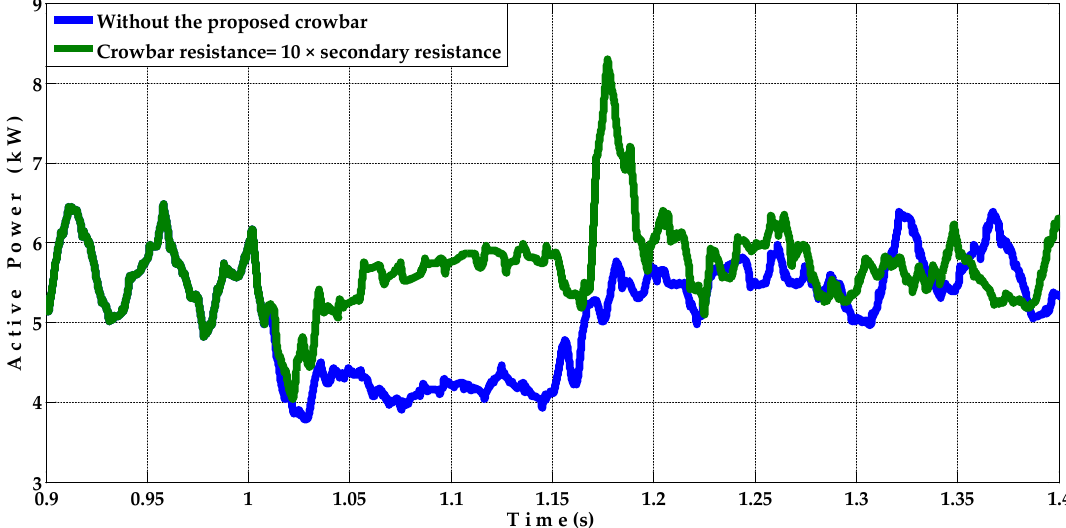
Figure 14. Active power of BDFRG with and without the proposed crowbar under single-line to ground fault occurrence.